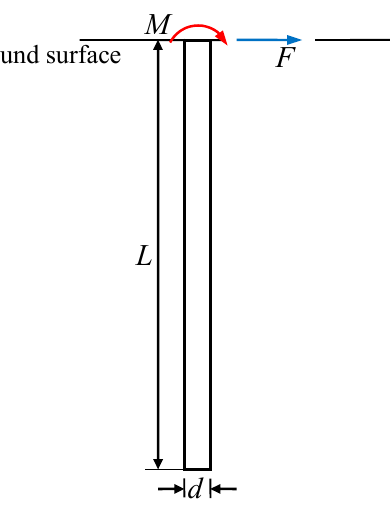
Figure 1. Laterally loaded pile.